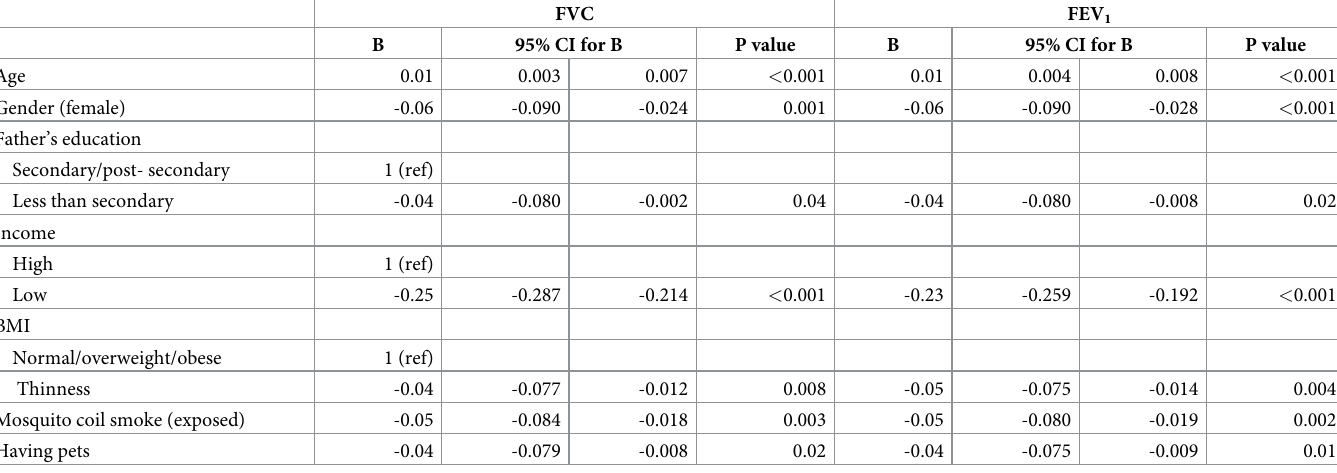
Table 3. Multivariate regression analysis for predictors of FEV 1 and